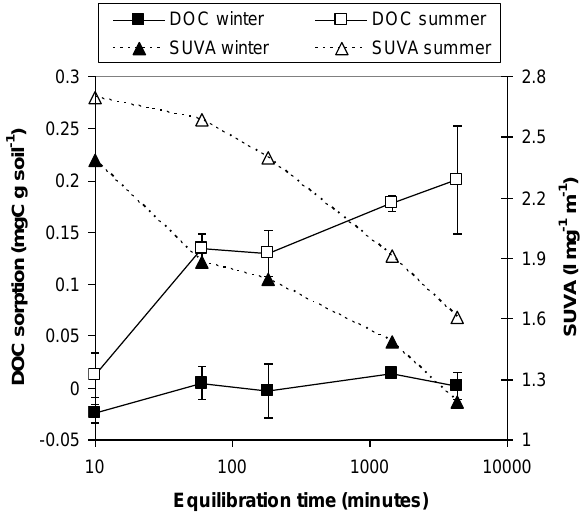
Figure 8. Time-dependant isotherm equilibration results for the sorption of O horizon soil solution DOC (collected in winter and summer) onto podzol Bs horizon subsoil. The net uptake of DOC and the composition (in terms of SUVA) for the final solutions are given for each time point.